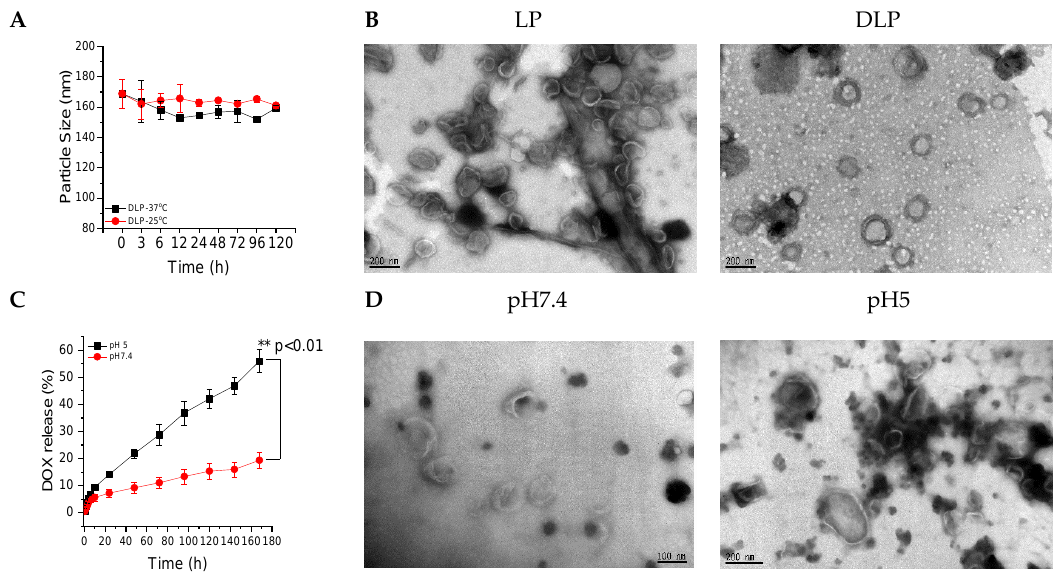
Figure 3. ( A ) The particle size of DLP at 25 °C and 37 °C surroundings. ( B ) TEM images of LP and DLP lipopolyplexes. The scale bars were 200 nm. ( C ) Accumulative release of DOX from DLP at pH 7.4 and 5.0. ( D ) TEM image of DLP after 6 h of incubation at pH 7.4 and pH 5.0. The scale bars for left and right panel were 100 and 200 nm, respectively. Data were expressed as mean ± SD values ( n = 3). ** p < 0.01.